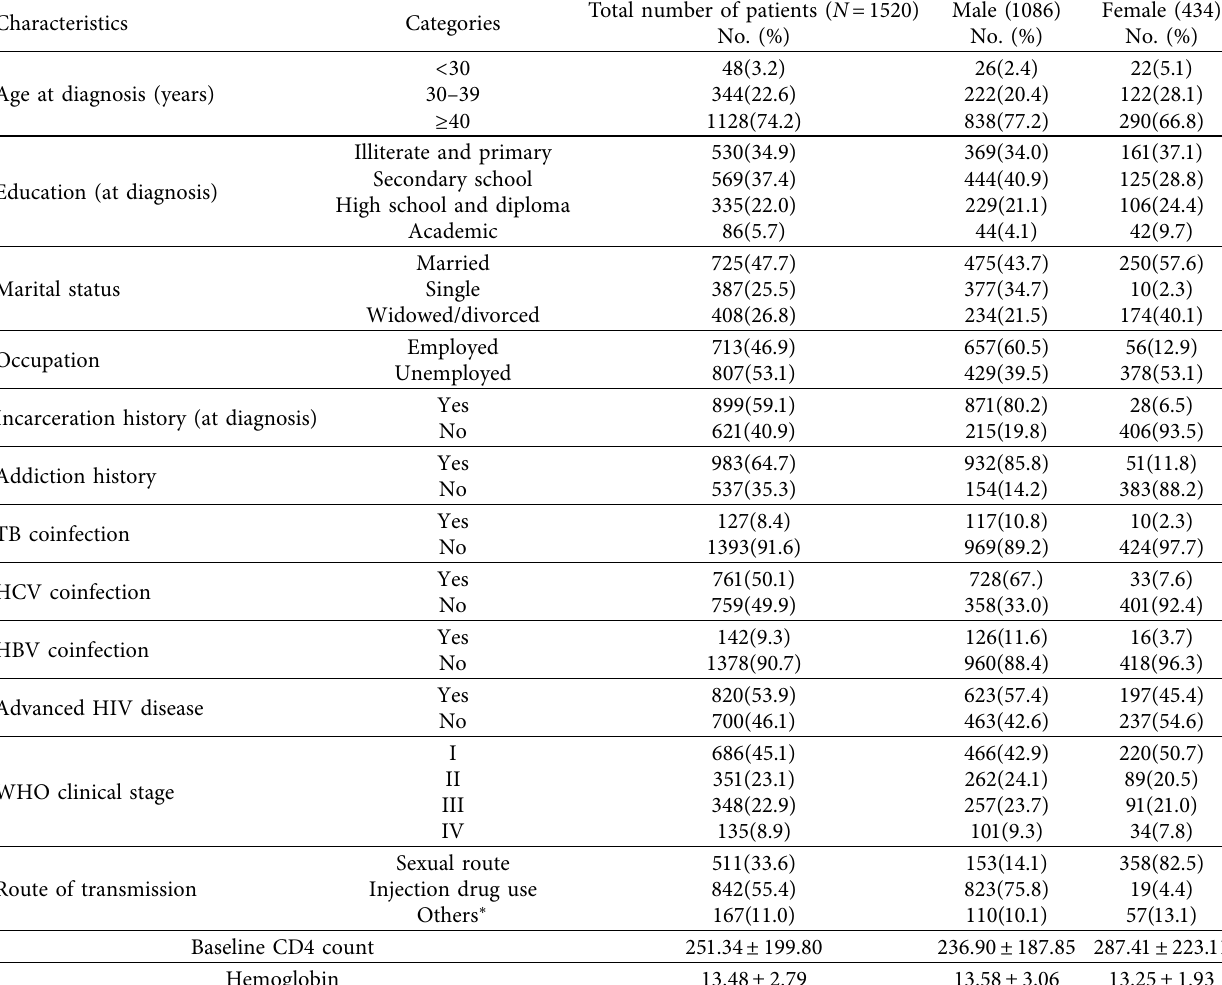
Table 1: Analysis of the demographic and clinical of HIV-positive patients according to